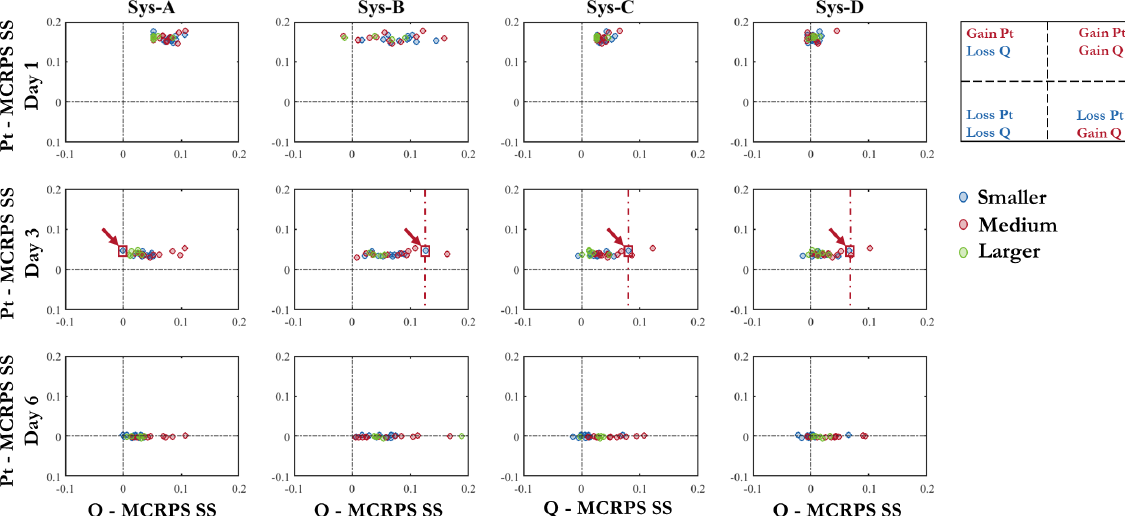
Figure 9. MCRPS skill score of precipitation forecasts against the MCRPS skill score of streamflow forecasts after application of the CSGD precipitation post-processor. The skill scores are computed using raw forecasts as a reference. Results are shown for lead times of 1, 3, and 6d and catchment group. The red box and arrows in the middle panels highlight the interaction of the precipitation post-processor with the different sources of uncertainty for the same